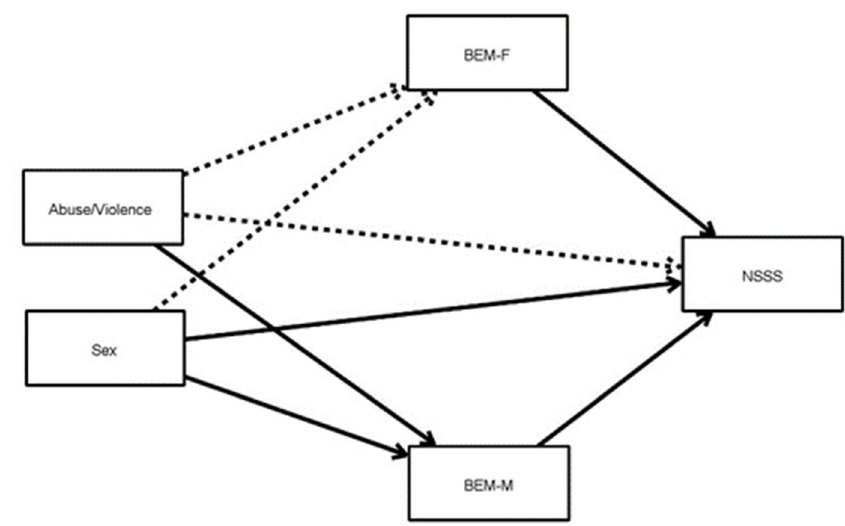
Figure 2. Mediational model. Categorical independent variables (factors) are shown with only one rectangle, but their effect is estimated using contrast variables. BEM-M = Male behaviors, BEM-F = Female behaviors; NSSS = New Scale of Sexual Satisfaction. Table 2. Indirect and total effect from mediation analysis for ISD and NSSS.